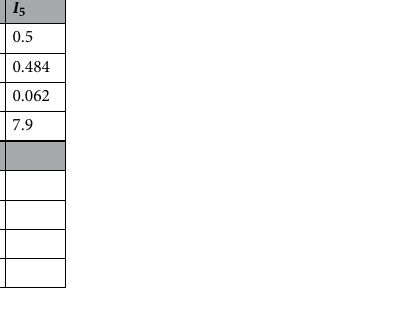
Table 4. Calibrated results for the case of ten